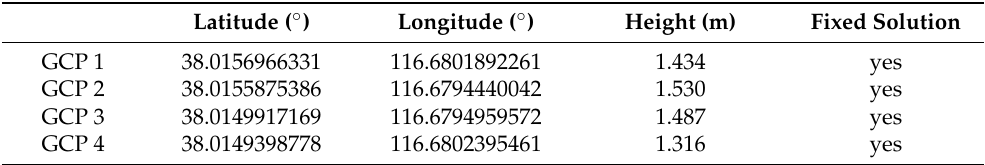
Figure 2. The sets of calibration targets and the measured reflectance from ASD-HH2. ( a ) represented the deployment of 60% panel, ( b ) represented the deployment of 5% panel, and ( c ) was the reflectance of two panels measured using ASD-HH2, the line in orange and blue colors represented the 60% and 5% panels, respectively. Table 1. The detailed geo-location information of the ground control point (GCP) measured using the real-time kinematic (RTK) S86T system. The columns each present the locations of the GCP, and fixed solutions indicate the measurement was stable. The rows each represent the series number of the